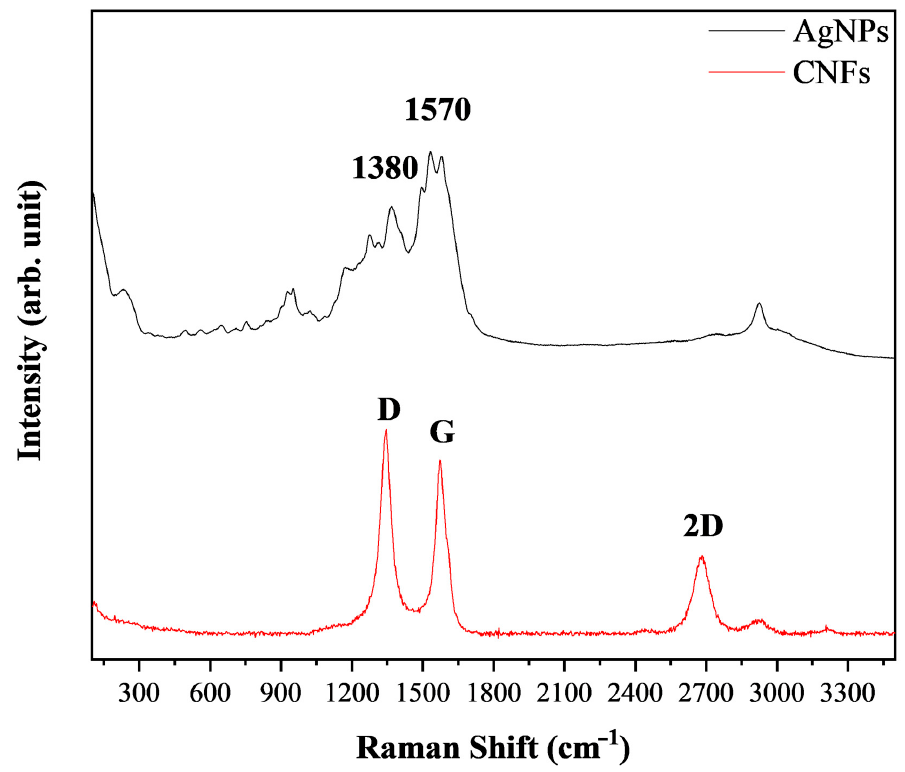
Figure 3. Rama spectra of silver nanoparticles, AgNPs and carbon nanofibers, CNFs. The most representative AgNP Raman peaks (1380 and 1570 cm − 1 ) and CNFs (D, G, and 2D bands) are indicated in Figure 3.